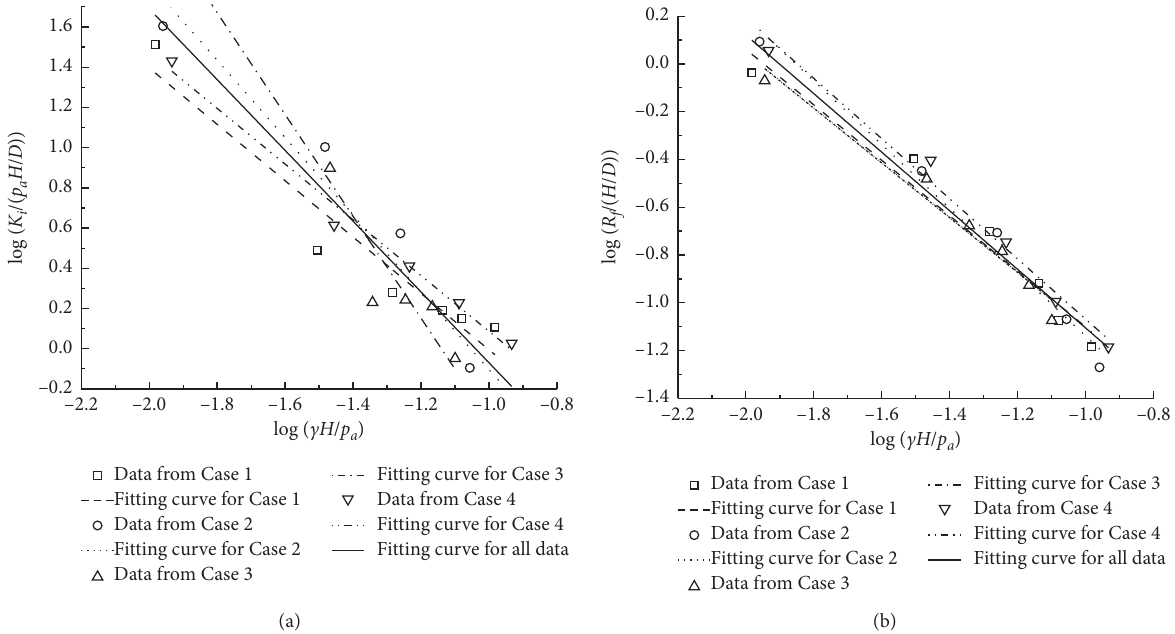
Figure 19: Fitting process curve. (a) K